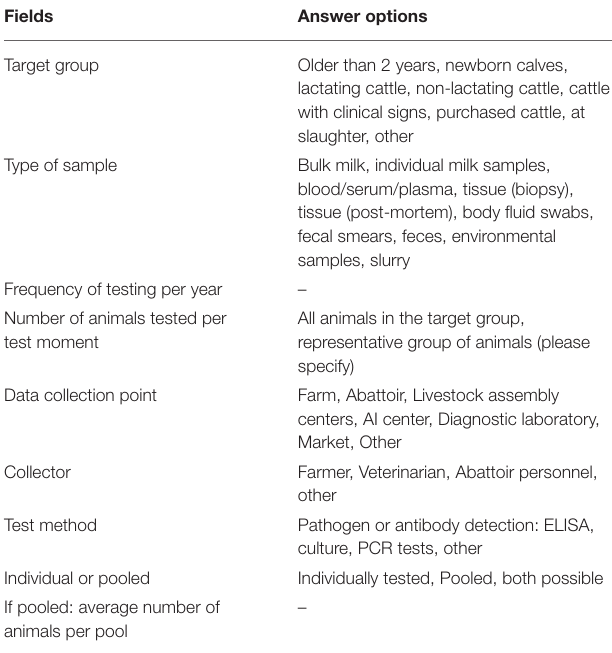
TABLE 3 | Test strategy variables with answer options for BVD, JD, and